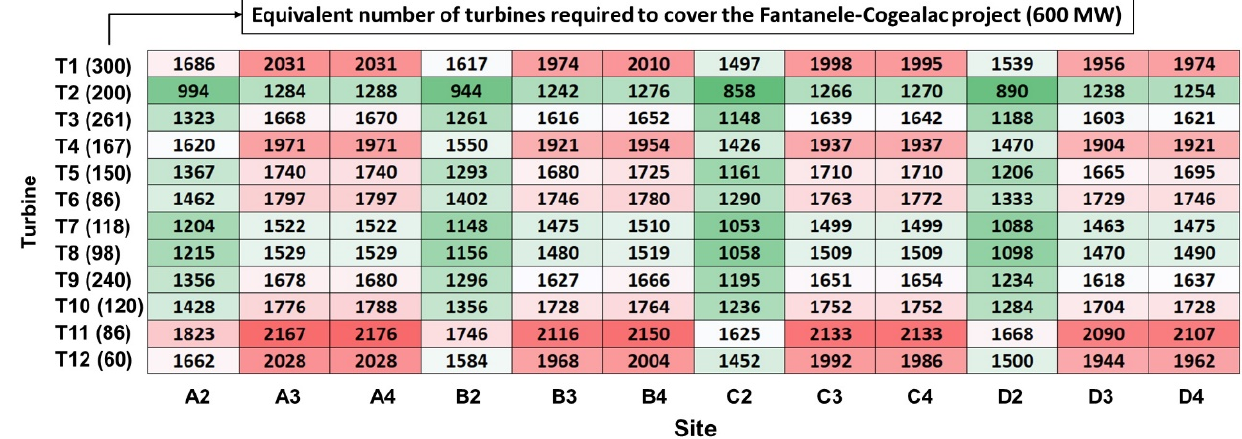
Figure 11. Expected AEP (in GWh) indicated by a wind farm that replicated the Cogealac–Fantanele project (600 MW capacity). Results corresponding to the interval 2000–2019, where, for example, T2 (200) means that from 200 wind turbines (V100–3.0) a total of 994 GWh will be generated for the site A2.